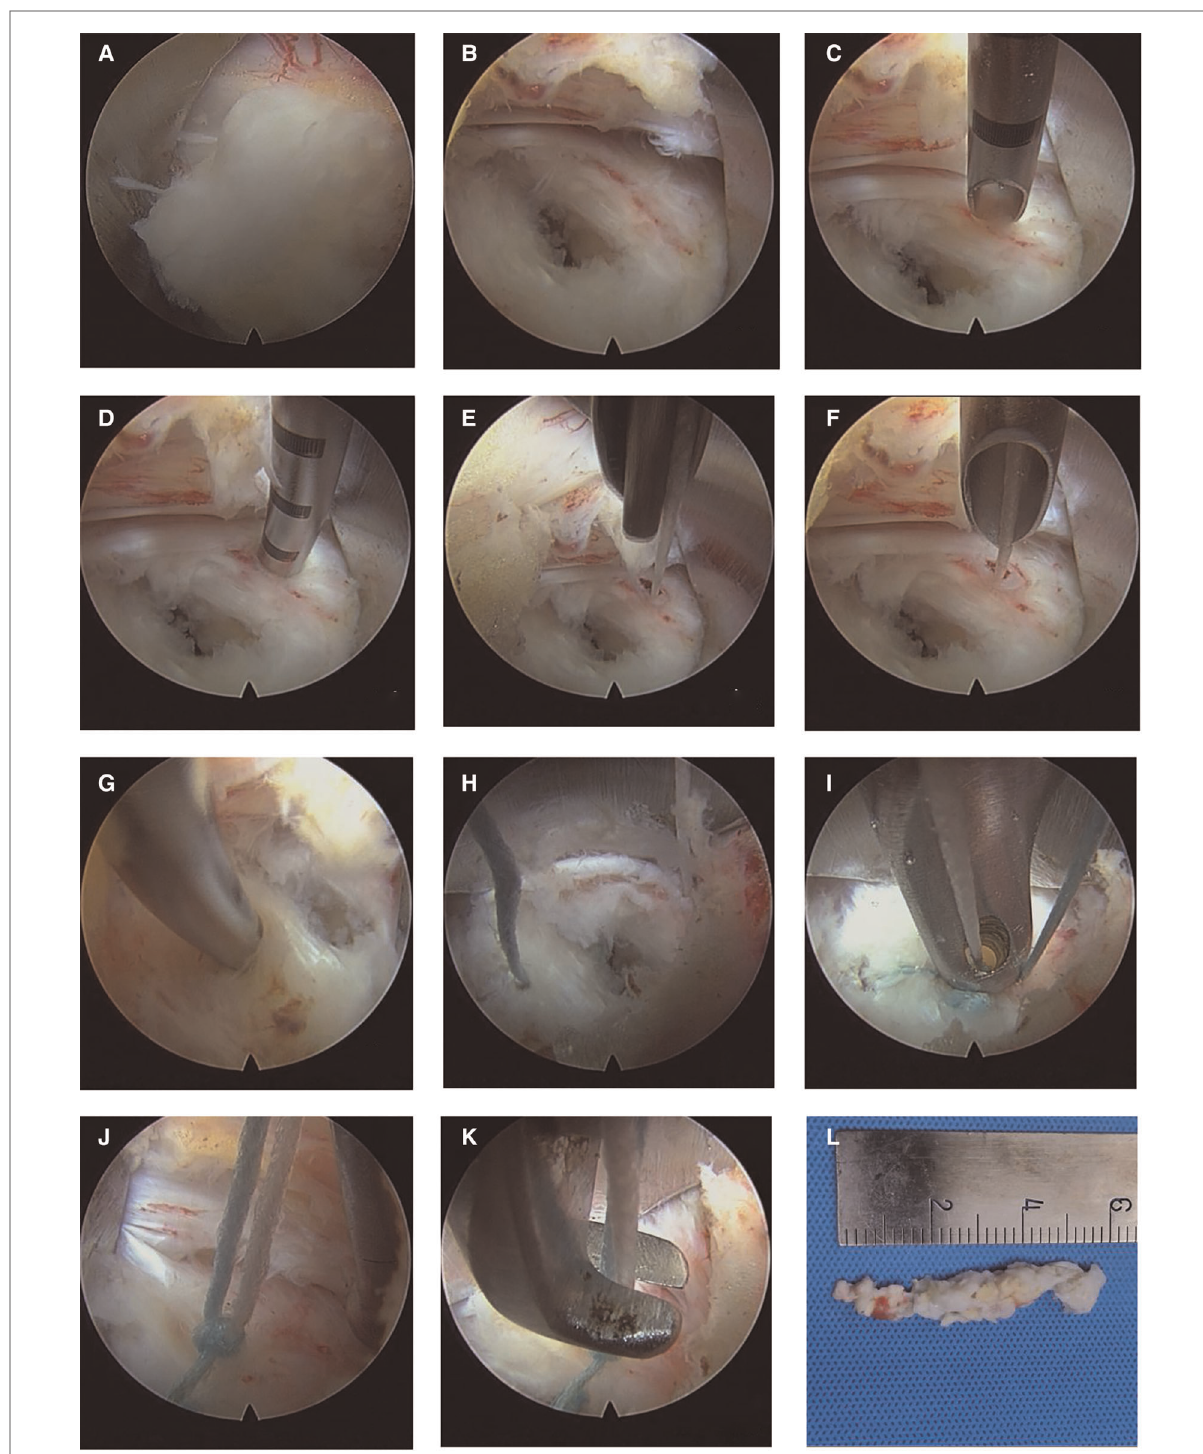
FIGURE 1 Intraoperative visualization of the annulus fi brosus suture process. ( A ) Exposure of the protruding nucleus pulposus via the interlaminar approach. ( B ) Excision of the nucleus pulposus reveals the damaged annulus fi brosus and an annulus fi brosus defect of about 5 mm. ( C,D ) The suture needle is inserted into the healthy annulus fi brosus 5 mm from the defect. ( E,F ) The guide-needle is used to push in the white suture with the anchoring device. ( G,H ) The same method is used to place blue sutures in the lateral healthy annulus fi brosus. ( I,J ) Placement of the knotted bilateral anchor line. ( K ) Suture cutting. ( J ) Excised nucleus